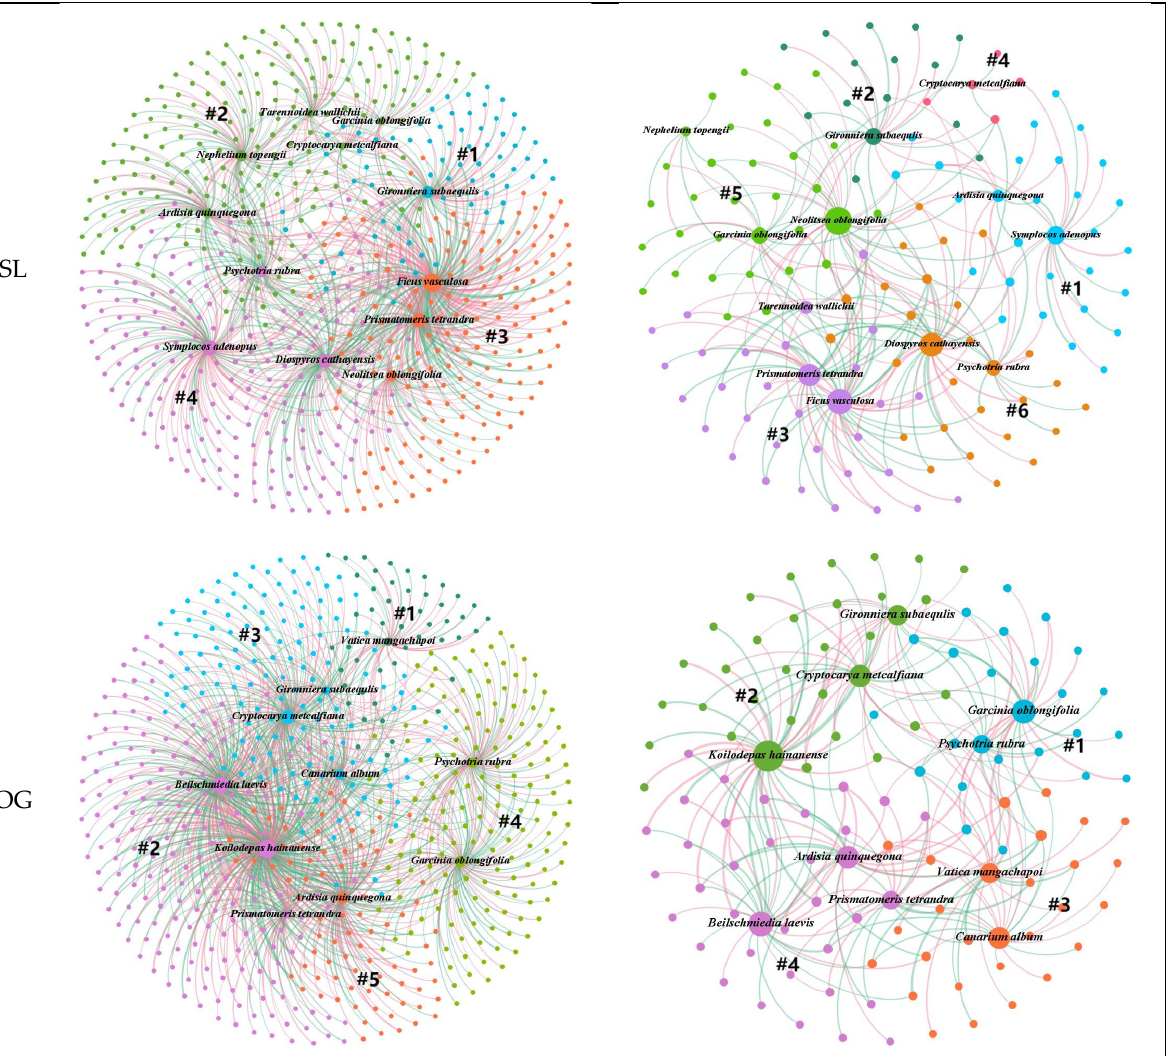
Figure 1. The plant–microbe module separation results. Different colors represent different modules and are represented by # numbers. The node size represents the node degree. SB: slash-and-burn. CC: clear cutting. SL: selective cutting. OG: old growth forests.